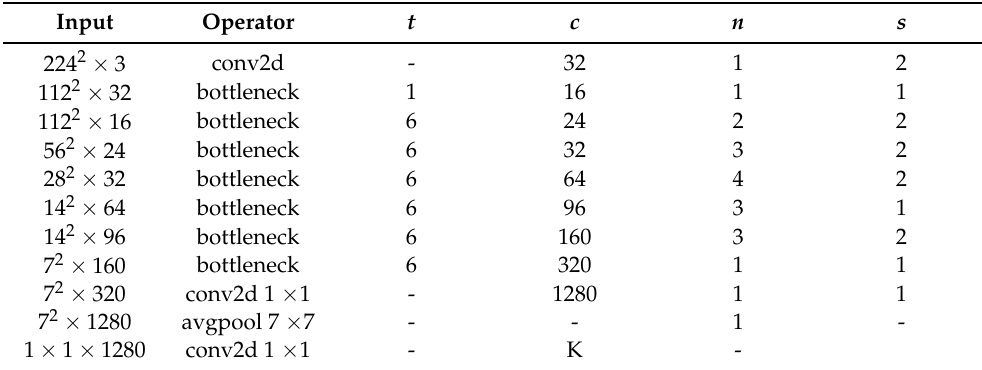
Table 1. MobileNetV2 overall architecture